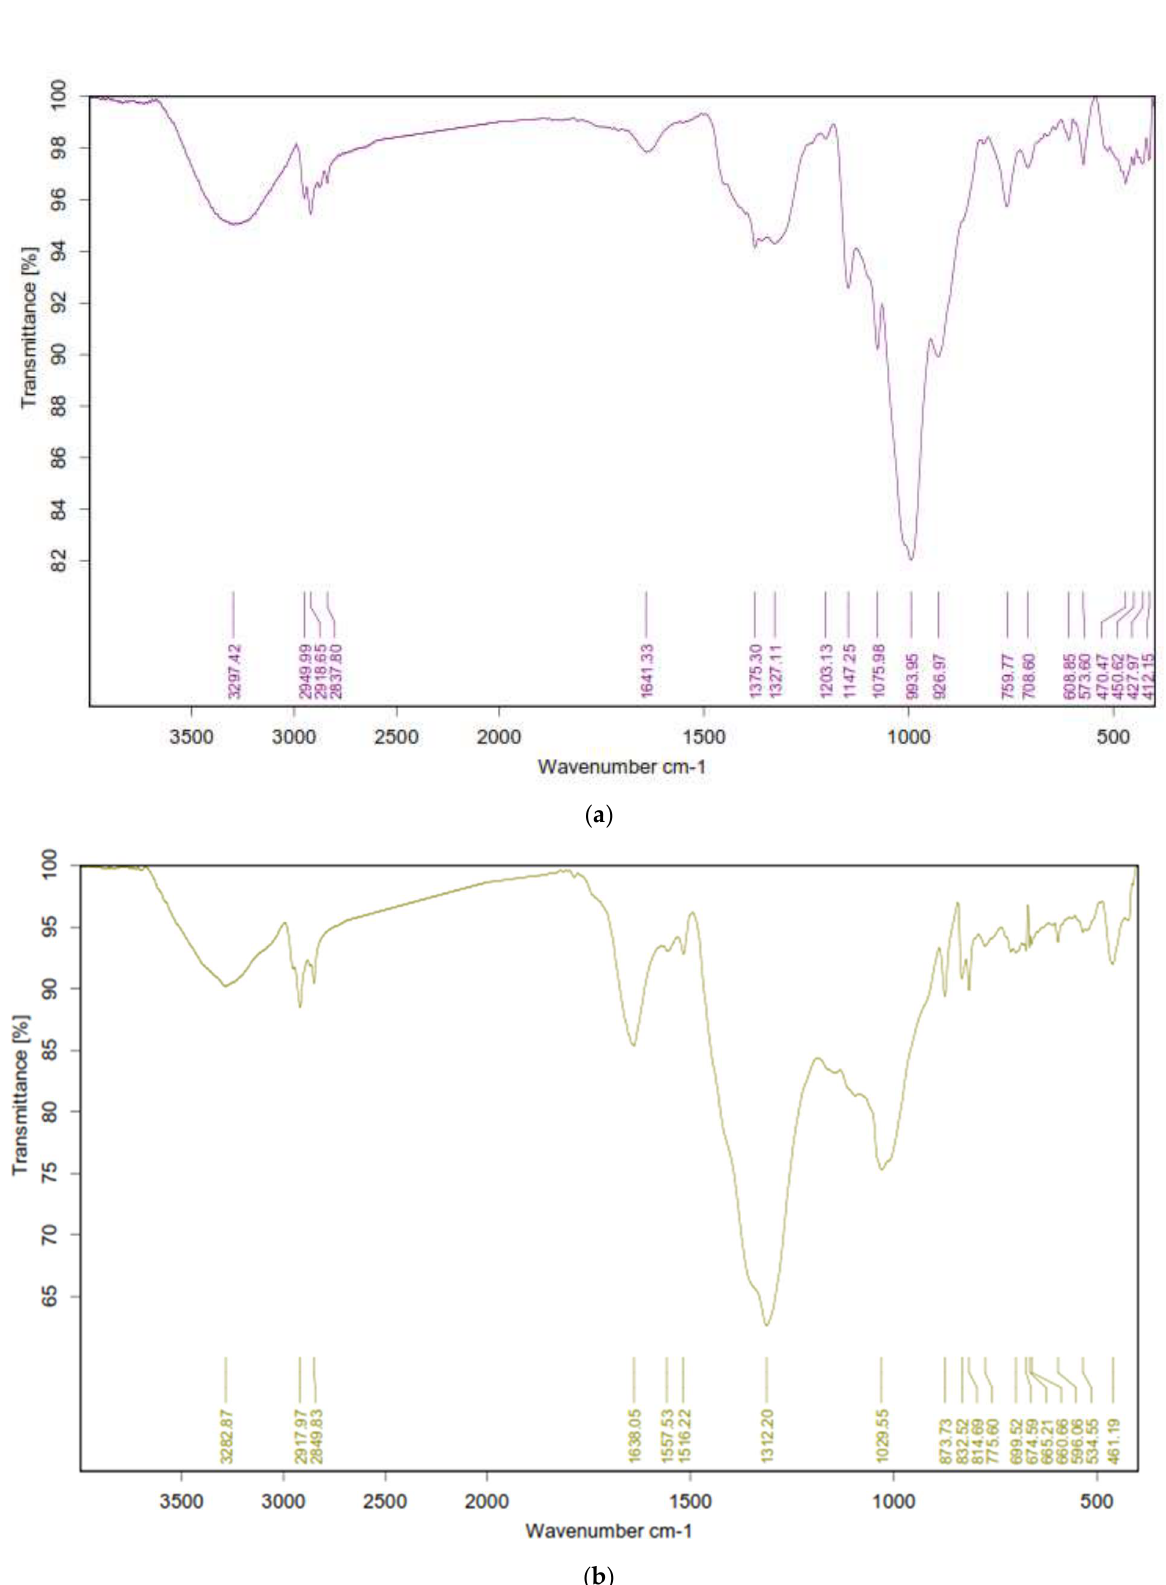
Figure 5. FTIR spectra of the green prepared AgNPs using CE ( a ) and EE extract ( b ).